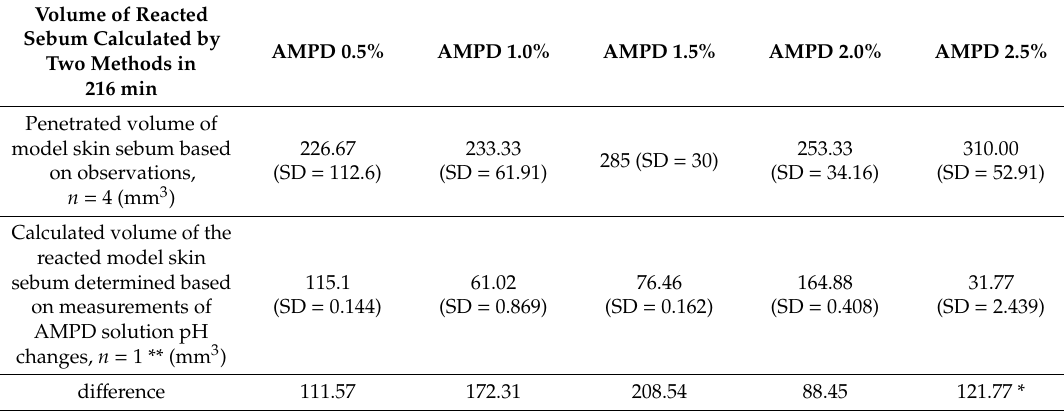
Table 3. Values of penetrated volume and reacted volume after 216